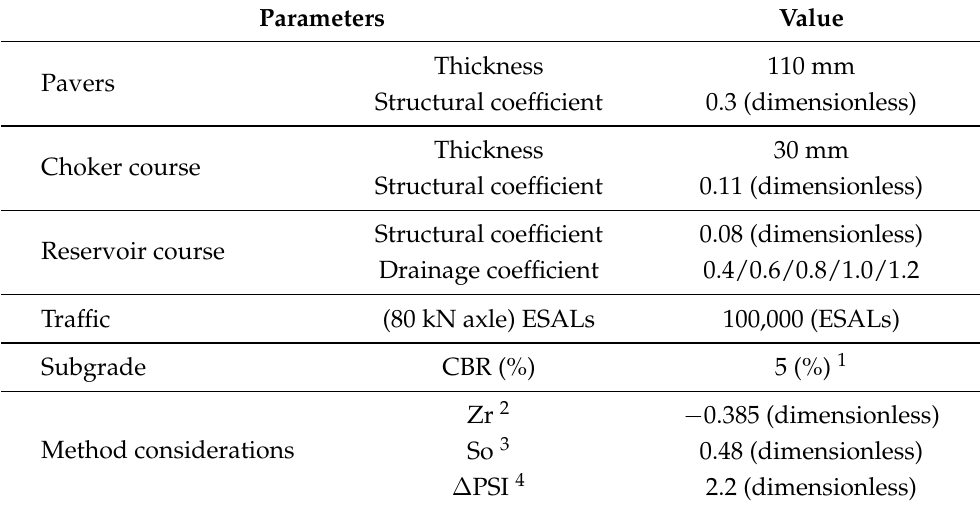
Table 8. Structural design